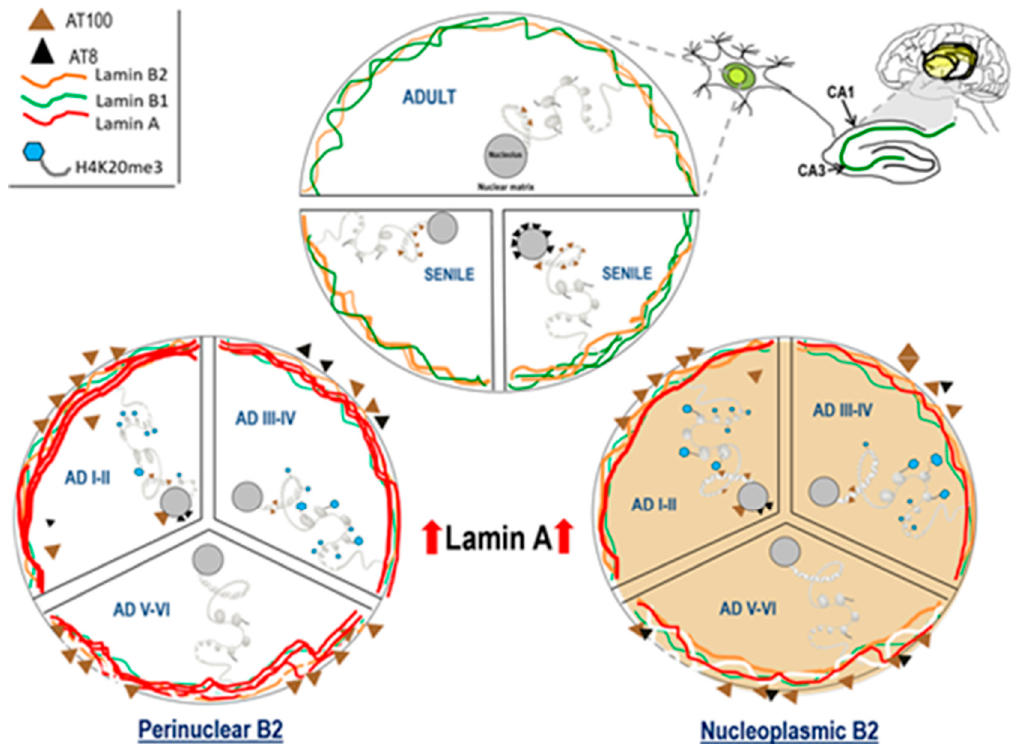
Figure 8. Nuclear dynamics of Tau, nuclear lamins, and H4K20me3 in the hippocampus of adult, senile AD I-II, AD III-IV, and AD V-VI Braak stages. Adult neurons have low phosphorylated Tau-AT100 expression and Lamin B1 and Lamin B2 are the components of NL. Senile neuron increment their content of phosphorylated Tau-AT100 and AT8. Changes in Lamin B2 determine the two types of neurons, those with reinforced perinuclear Lamin B2 (left) and those with nucleoplasmic Lamin B2 (right). Lamin A (left) expression is associated with H4K20me3 repressive marks in LADs and NADs. The increased presence of cytoplasmic Tau leads to hyperphosphorylation, oligomer and NFT formation.